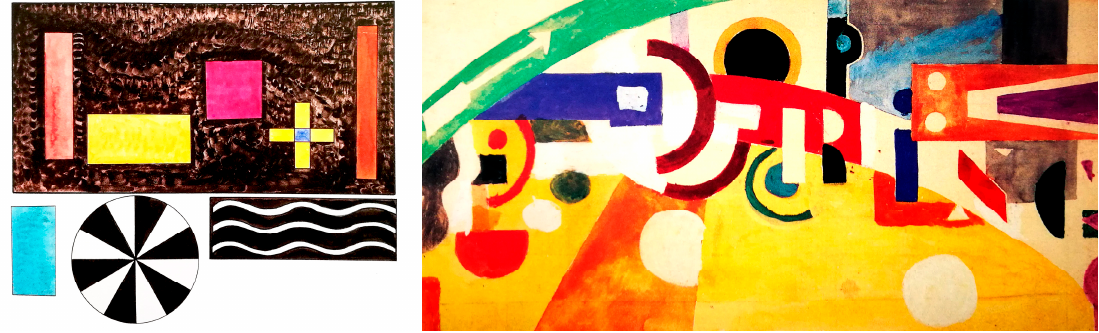
Figure 3. On the left, V. Kandinsky, Sketch for the scene VII, Bydlo, for ‘Paintings for an exhibition’, 1923; on the right, F. Léger, Sketch of the curtain for ‘Skating Rink’,